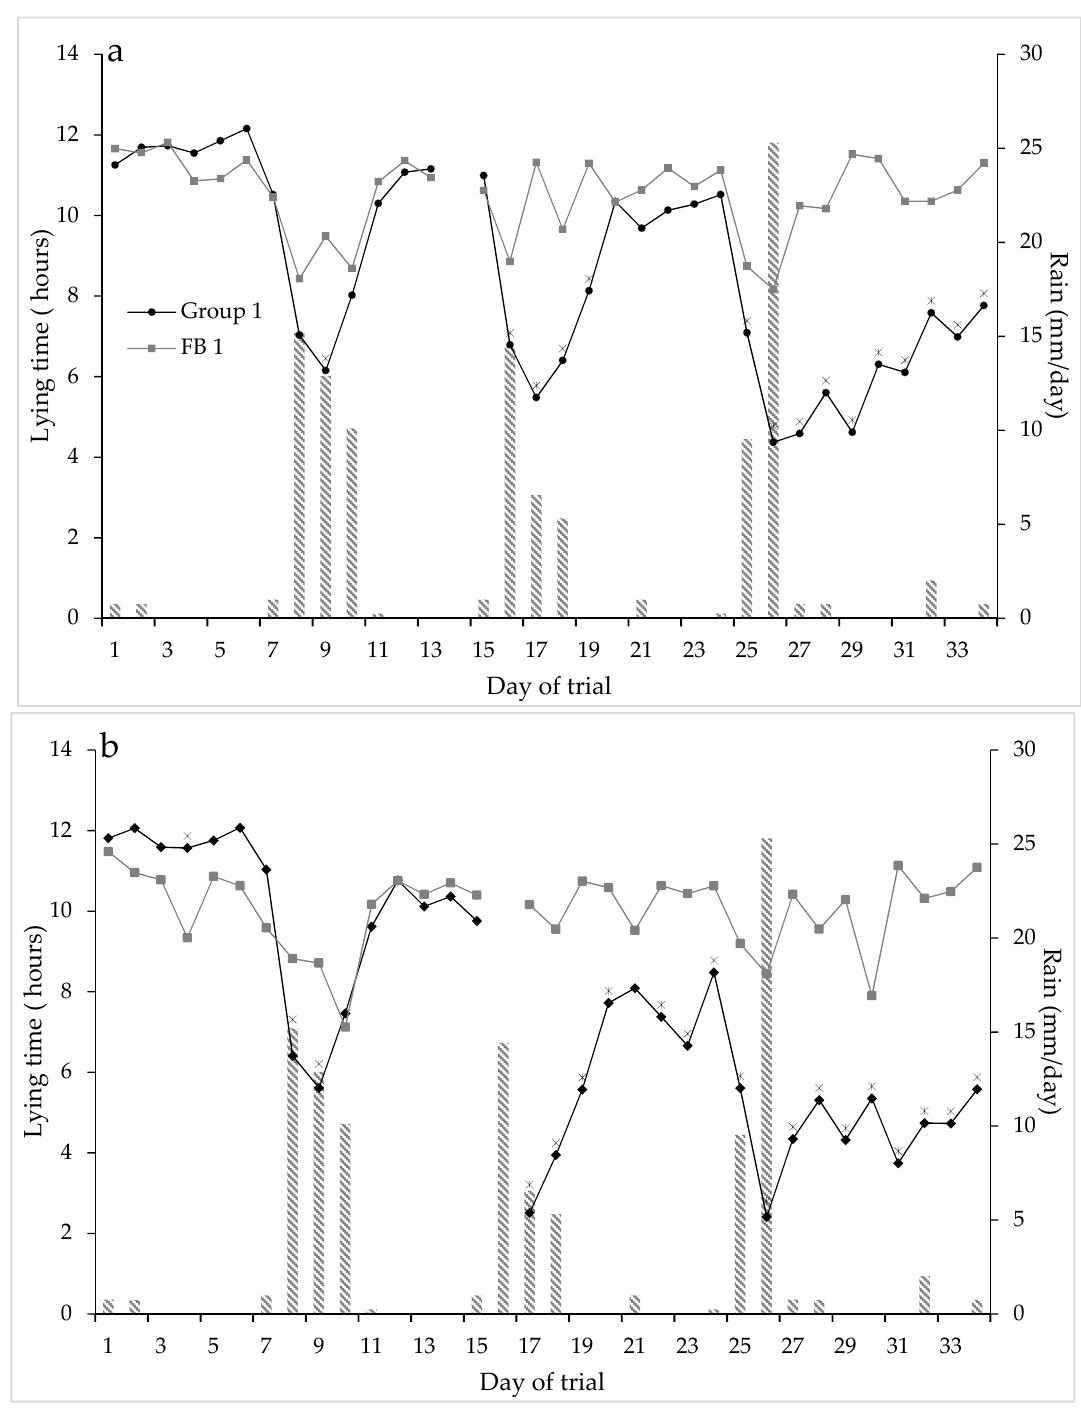
Figure 1. Total daily lying time (hours) over the 34 days of the trial for NFP Group 1 and FB 1 ( a ) and NFP Group 2 and FB 2 ( b ) (* indicates significance, p < 0.05, between the groups at each time point) over the five weeks of the trial. (Data logger change over days were excluded from the data). Rainfall (mm / day) during the trial period is also shown as bars. The percentage of cows that achieved 8 h lying decreased over time and was significantly different from the corresponding percentage in the FB groups on the same days considering total daily lying time, i.e., for the last 10 days for the NFP Group 1 (Figure 2: test of Time.Group: F 32,388 = 5.92; p < 0.001) and after 2 weeks on the pad (i.e., from Day 17) for the NFP Group 2 (Figure 2: test of Time.Group: F 30,289 = 6.42; p < 0.001).